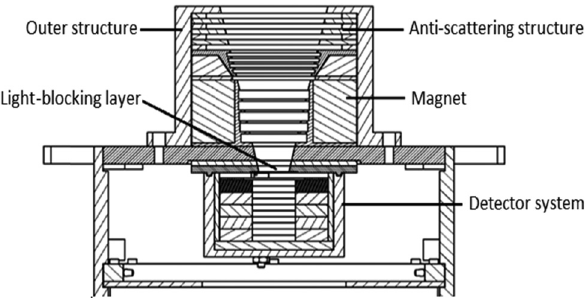
Figure 2: Schematic diagram of the HEPD structure.